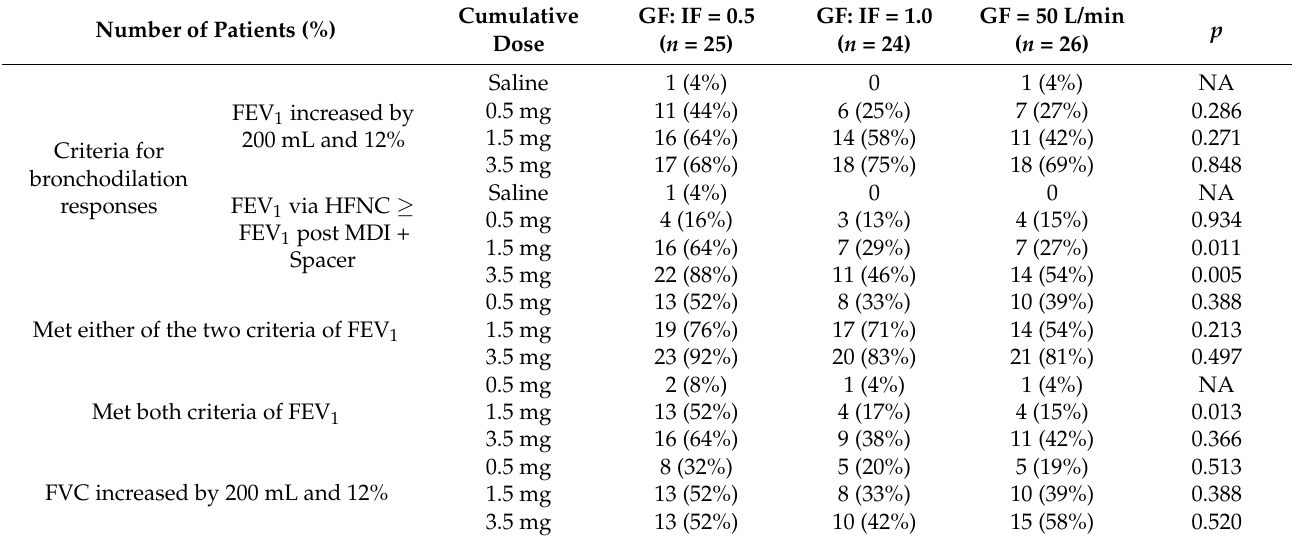
Table 2. Bronchodilation responses after inhaling salbutamol via HFNC among three groups. Number of Patients (%)